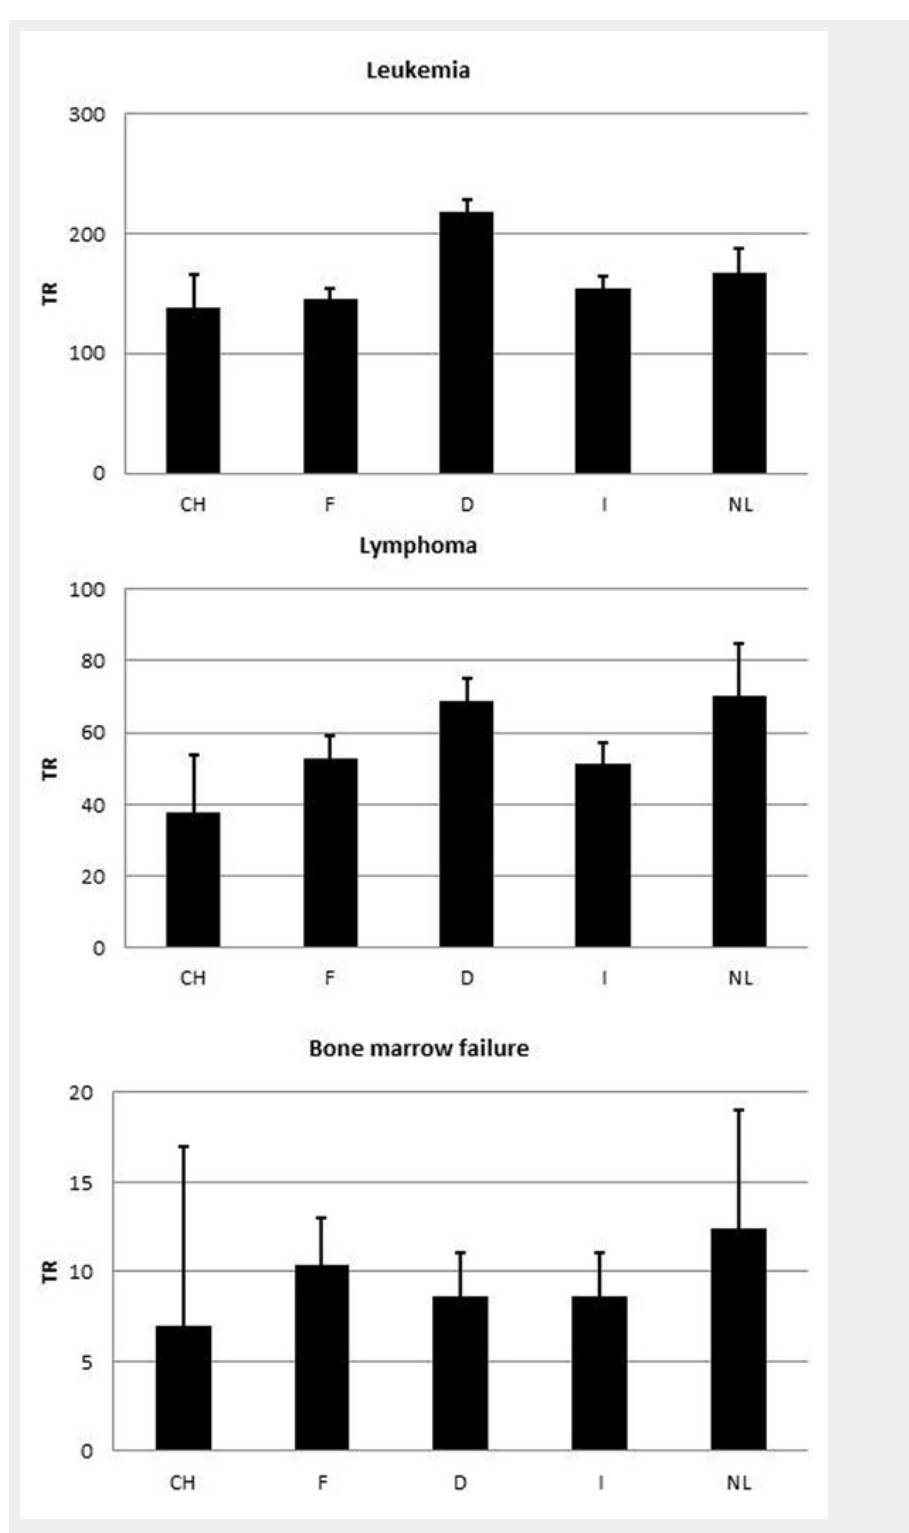
Figure 3 Allogeneic HSCT rates per 10 million inhabitants per year. 1a: leukaemia. 1b: lymphoma. 1c: bone marrow failures syndromes (CH: Switzerland, F: France, D: Germany, I: Italy, NL: the